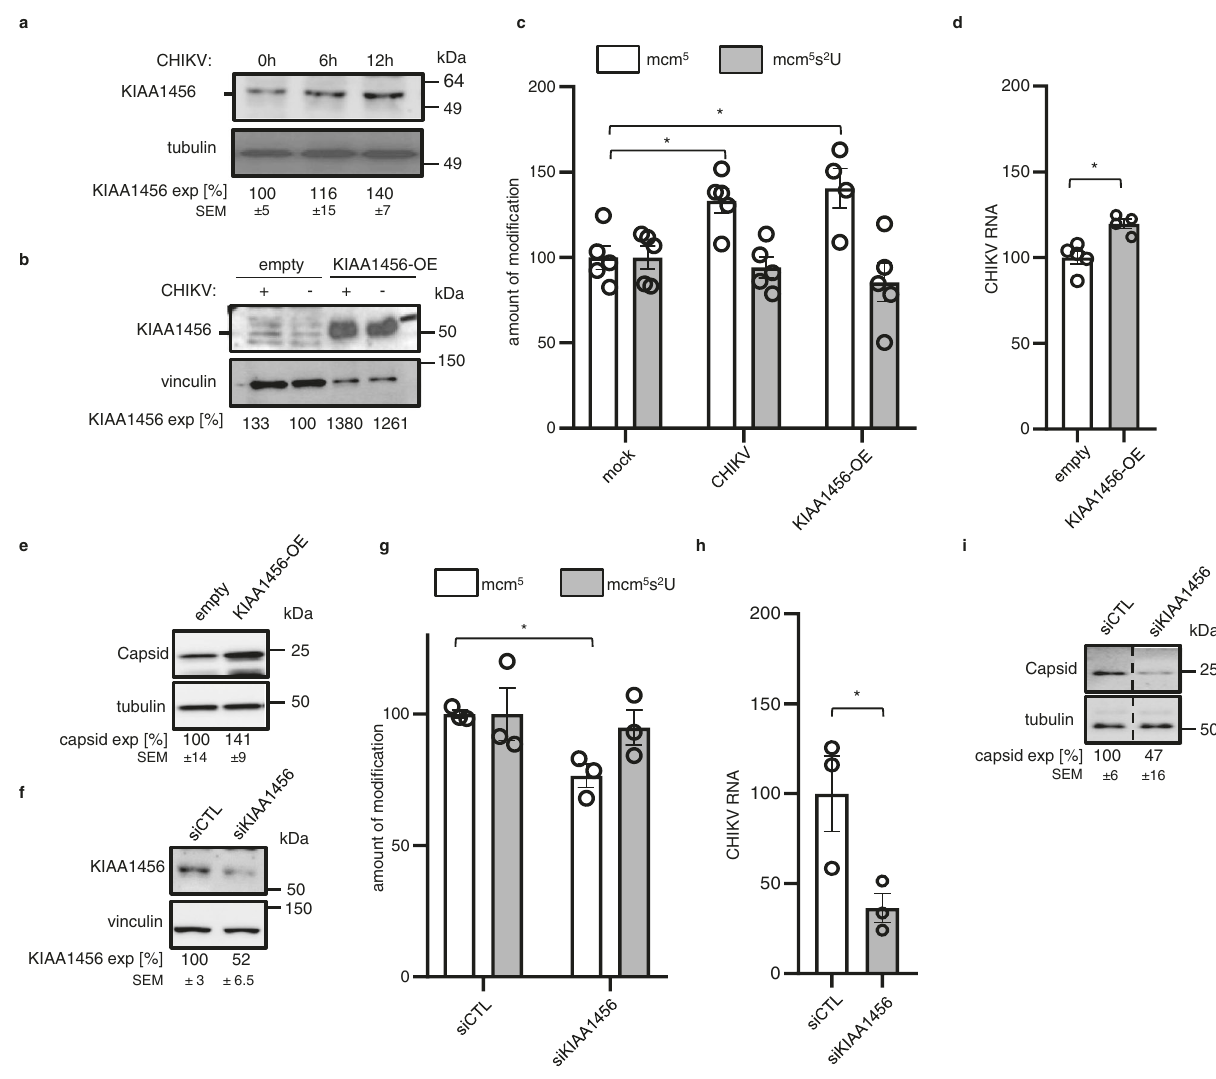
Fig. 5 Effect of KIAA1456 overexpression and depletion on mcm 5 U and mcm 5 s 2 U modi fi cation levels and on CHIKV infection. a Western blot showing KIAA1456 protein upregulation upon CHIKV infection. Values denote relative KIAA1456 expression normalized by tubulin expression calculated from 3 independent replicates and expressed as mean ± SEM. b Western blot showing KIAA1456 protein levels under plasmid-driven overexpression (KIAA1456- OE) and CHIKV infection conditions. Values represent relative KIAA1456 expression normalized by vinculin expression. A representative example from two independent replicates is shown. Note, that to be able to compare expression levels, 1:5 dilutions of the KIAA1456 – OE overexpression samples were loaded. c Relative mcm 5 U and mcm 5 s 2 U modi fi cation levels in mock-infected cells, CHIKV-infected cells and in cells overexpressing